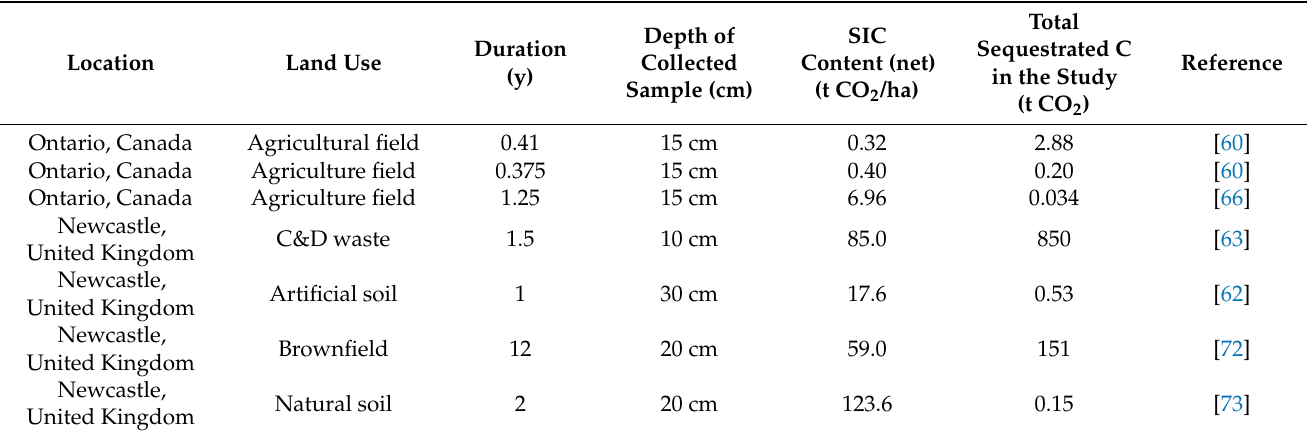
Table 1. CO 2 fixation uptakes (on areal and total basis) reported in ERW studies conducted at